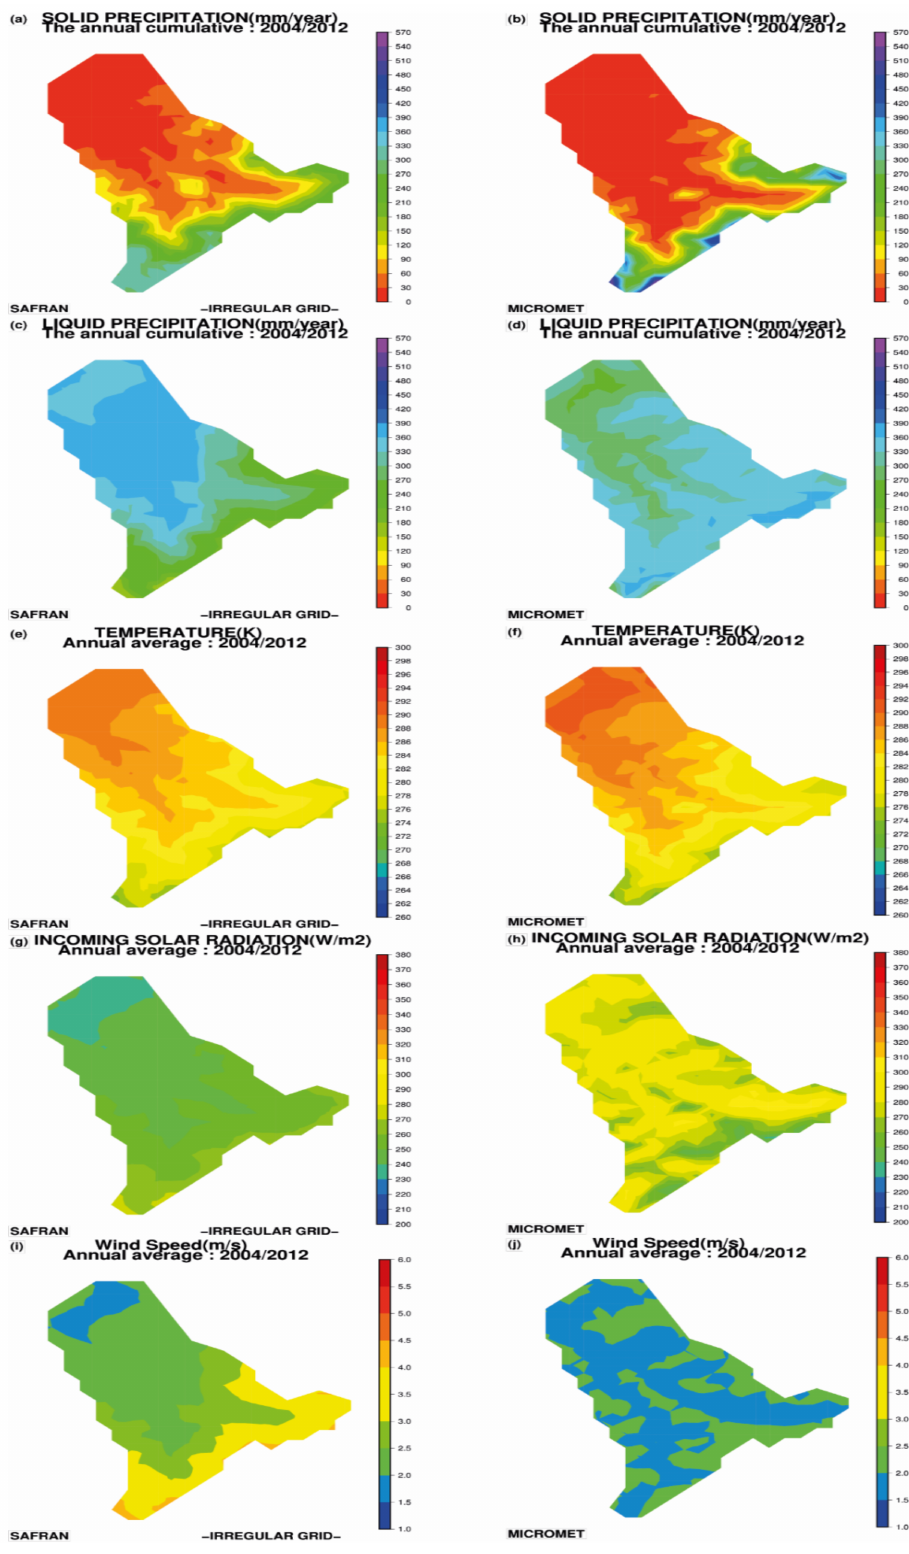
Figure 3. Map of yearly average snowfall ( a , b ), rainfall ( c , d ), air temperature ( e , f ), incoming solar radiation ( g , h ) and wind speed ( i , j ) for the two models SAFRAN ( left ) and MicroMet ( right ) on the Rheraya sub-basin for the period